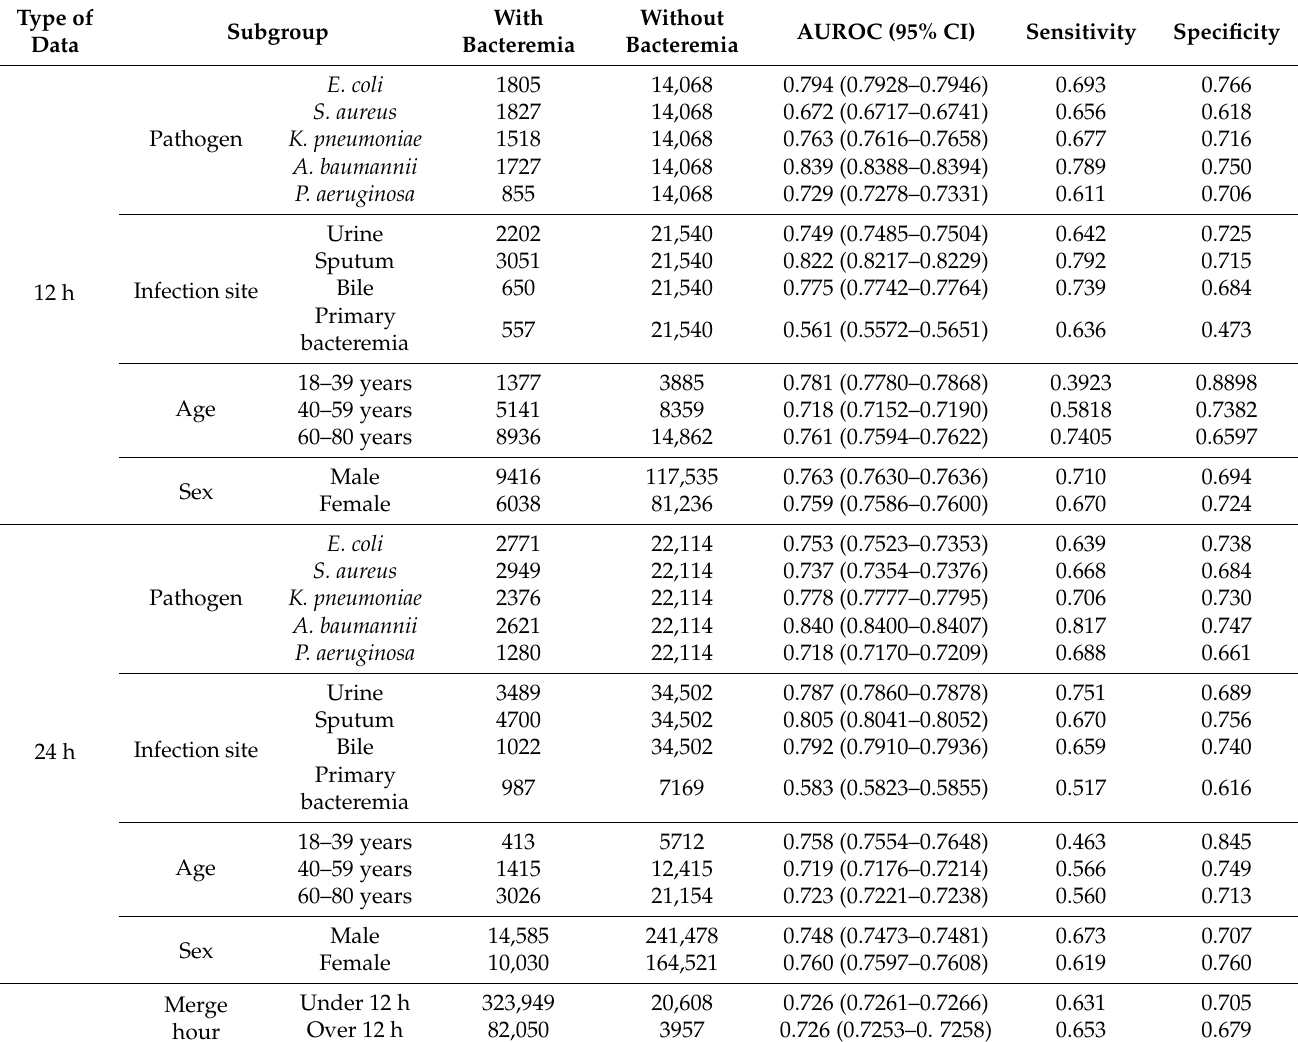
Table 3. Subgroup analysis of bacteremia prediction according to causing pathogen, infection site, age, and